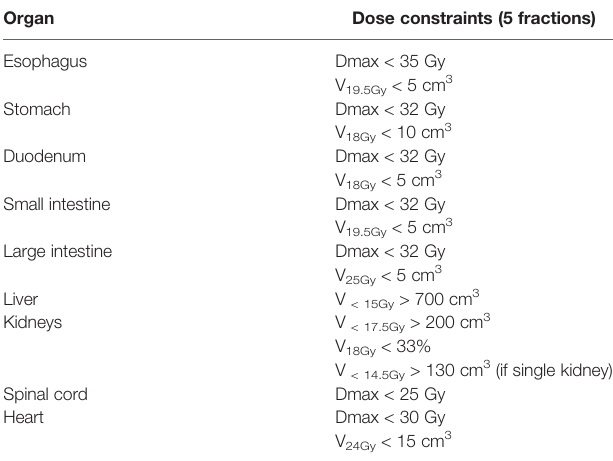
TABLE 1 | Organ at risk dose constraints. Organ Dose constraints (5